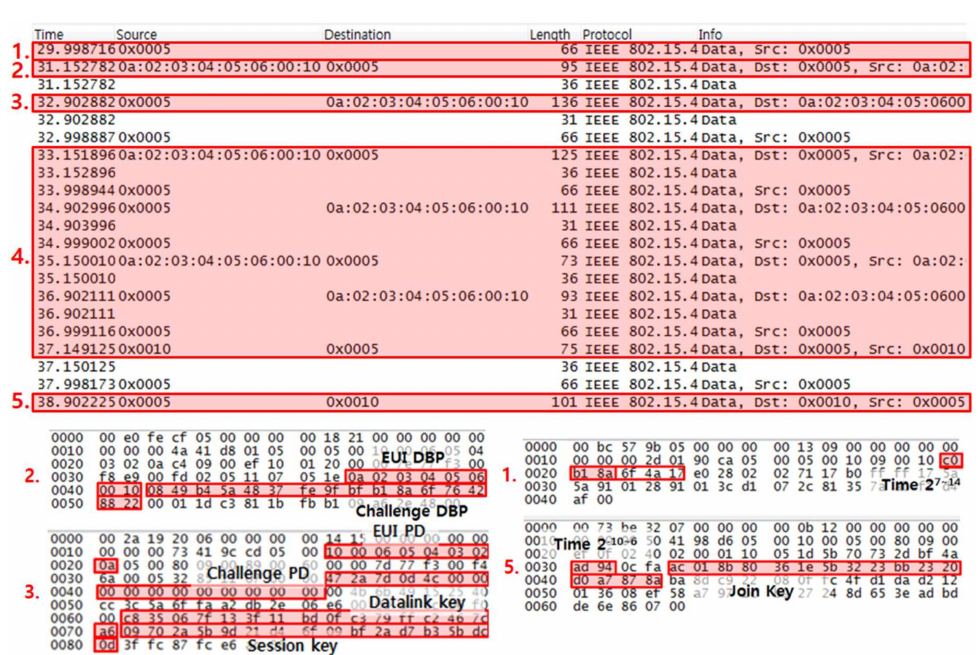
Figure 3’s third red-boxed packet. The process of encryption and decryption of AES-CCM* is the